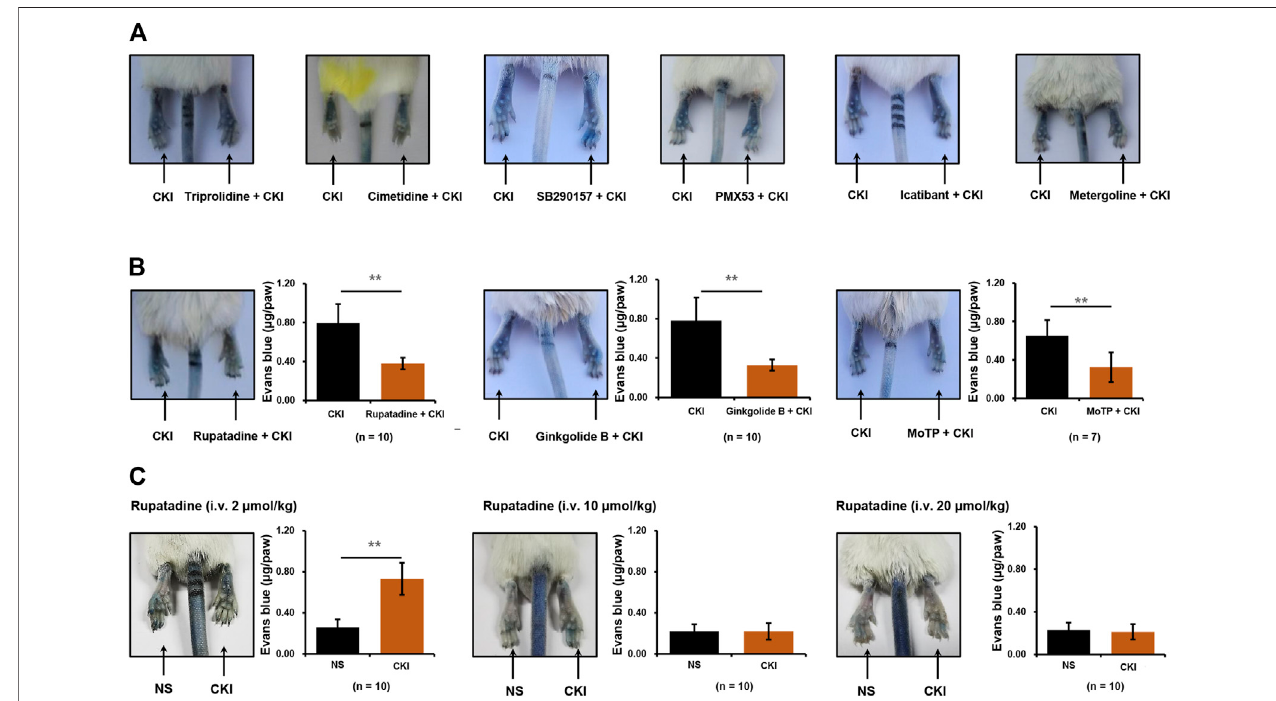
FIGURE 4 | CKI-caused Evans blue leakage can be blocked by PAF receptor antagonists (A) Representative images of CKI-induced Evans blue extravasation. Right paws of mice were intraplantarly injected with 10 μ l of different antagonists (60 mM triprolidine or 40 mM cimetidine or 3.8 mM SB290157 or 2 mM PMX53 or 1 mMicatibantor12.4 mMmetergoline),andtheleftpawswereinjectedwith10 μ lofNS.Tenminuteslater,themicewereinjected(i.v.)withEvansblue(0.65 μ mol).Five minutes later, two paws were intraplantarly injected with CKI (10 μ l/paw). Thirty minutes later, the mice were euthanized and photographed. (B) Representative images of Evans blue extravasation and quanti fi cation of Evans blue leakage in the paws with or without intraplantarly injecting PAF receptor antagonists (2 mM rupatadine or 2 mM ginkgolide B or 15 mM MoTP, 10 μ l/paw). ** p < 0.01. (C) Representative images of Evans blue extravasation and quanti fi cation of Evans blue leakage in the paws with or without intravenously injecting PAF receptor antagonist.The mice werepretreated (i.v.) with rupatadine (2 – 20 μ mol/kg) 30 min before Evans blueinjection(0.65 μ mol).FiveminutesafterEvansblueinjection,rightpawsofmicewereintraplantarlyinjectedwithCKI(10 μ l/paw),andtheleftpawswereinjectedwith 10 μ l of NS. Thirty minutes later, the mice were euthanized. Paw tissues were collected and Evans blue in the paw tissues was extracted by DMF at 50 ° C overnight ( > 20 h). OD values were read at 620 nm. The concentration of the dye in the paw tissue was calculated according to the standard curve of Evans blue. ** p < 0.01. CKI, Compound Kushen Injection; NS, normal saline; OD, optical density; PAF, platelet-activating factor.